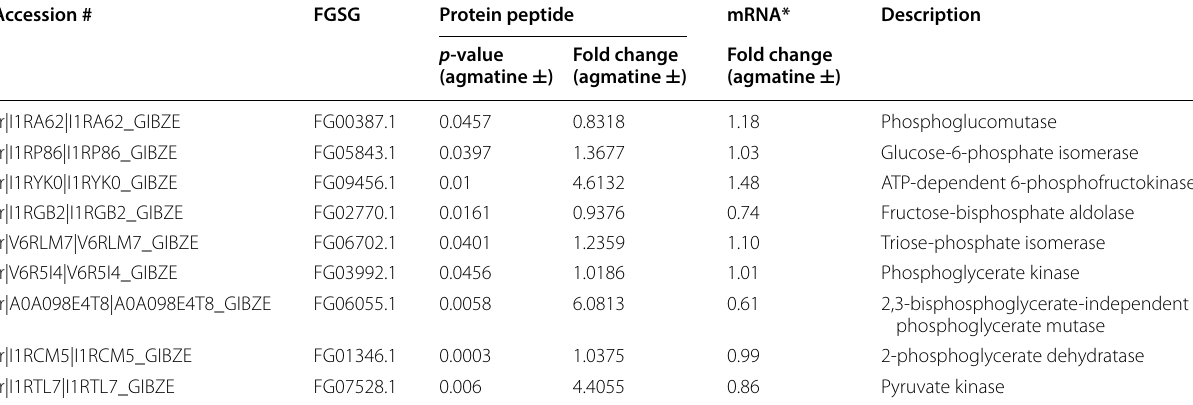
Protein peptides were detected using LC–MS/MS as described in the “Materials and methods” section. The data marked with asterisk (*) are quoted from Suzuki et al. (2013)